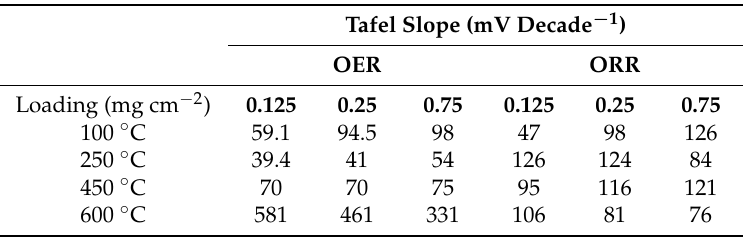
Table 2. Tafel characteristics of the Ni Fe oxide at the different temperatures.